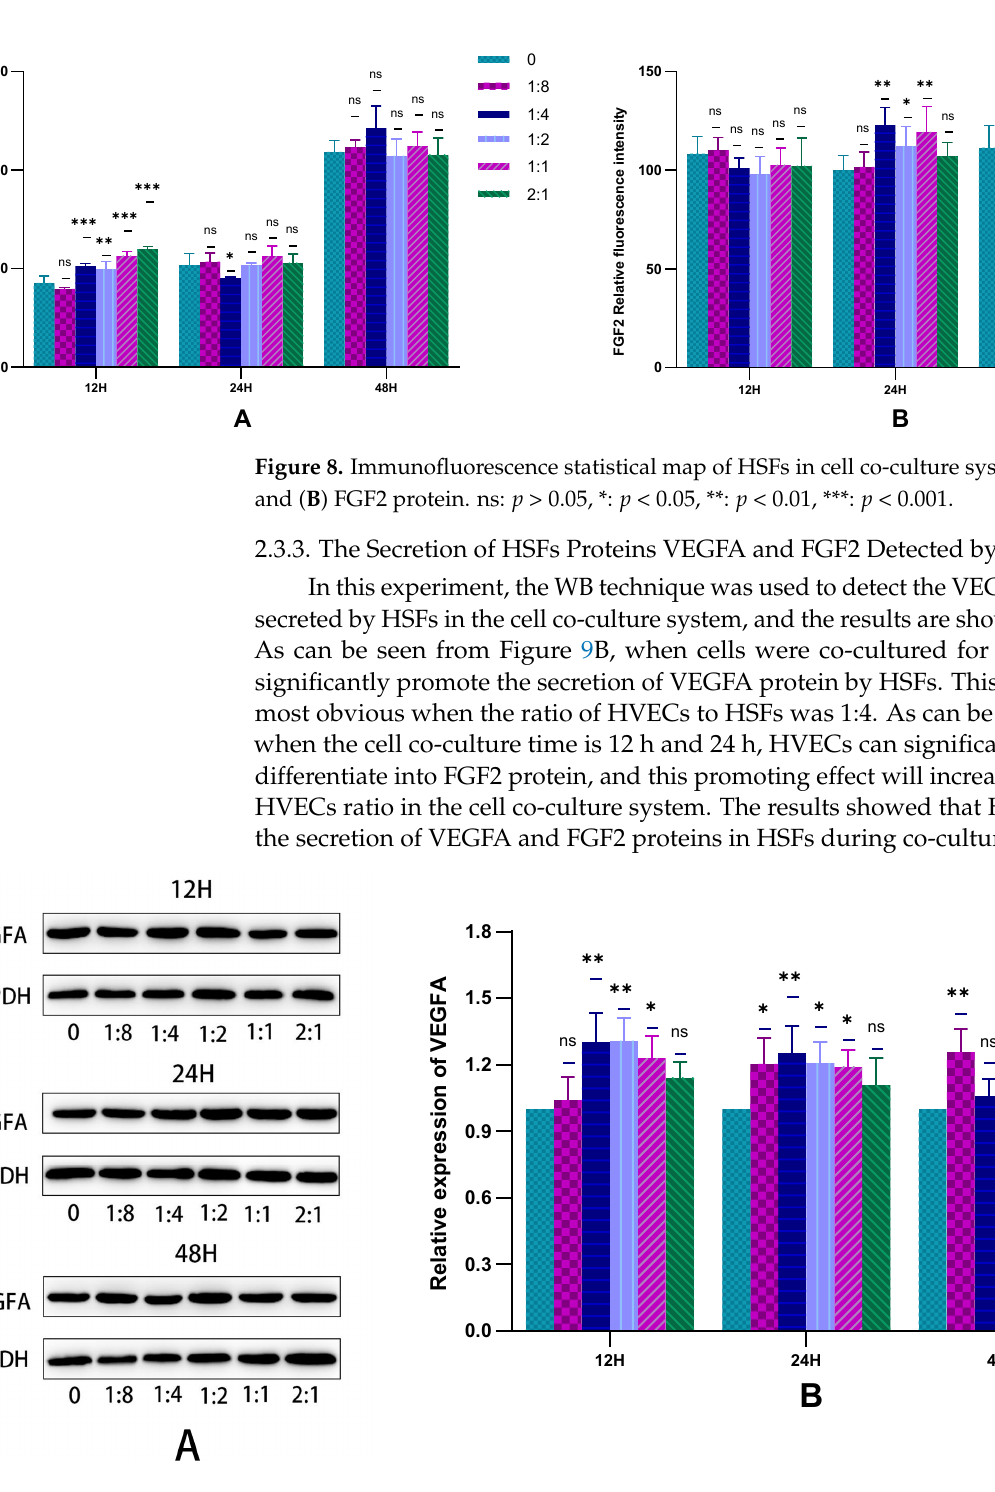
Figure 9. In the cell co-culture system, the WB detection map of VEGFA protein secreted by HSFs. ( A) The WB map of VEGFA protein secreted by HSFs after cell co-culture for 12 h, 24 h, and 48 h. ( B ) The statistical results of relative expression of VEGFA protein secreted by HSFs. ns: p > 0.05, *: p < 0.05, **: p < 0.01.